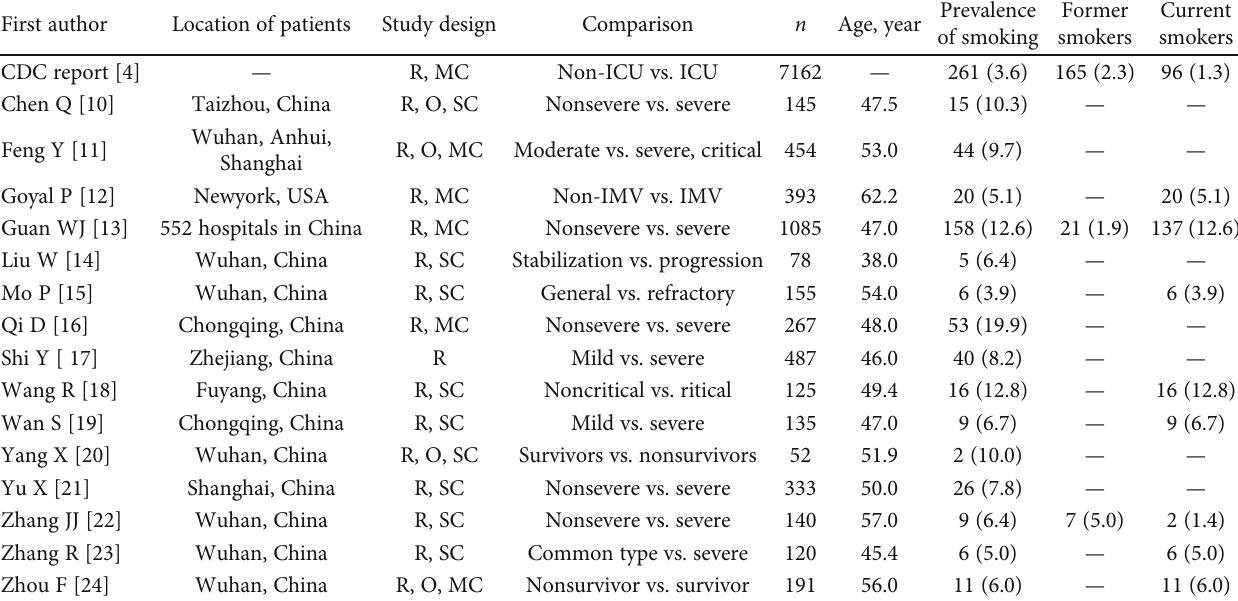
Table 2: Features of the studies included in the